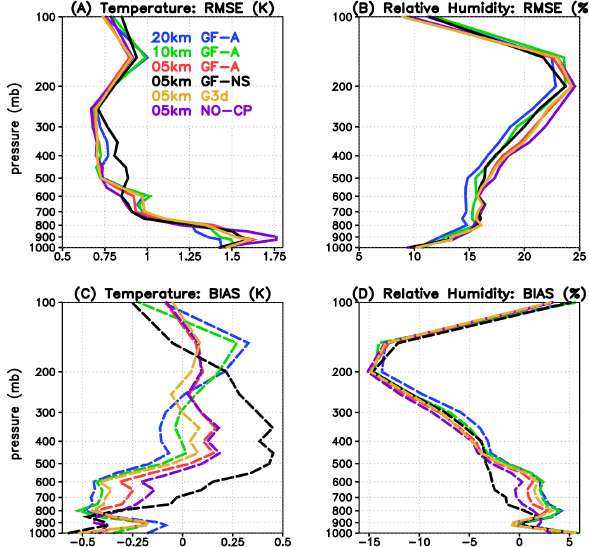
Figure 14. Vertical profiles of area averaged RMSE error (A, B) and Figure 14: Vertical profiles of area averaged RMSE error (A, B) and mean error for Temperature (A, C) and relative humidity (B, D). Units are degree C for Temperature and percent for relative humidity. mean error for Temperature (A, C) and relative humidity (B, D) . Units are in ◦ C for Temperature and percent for relative humidity.